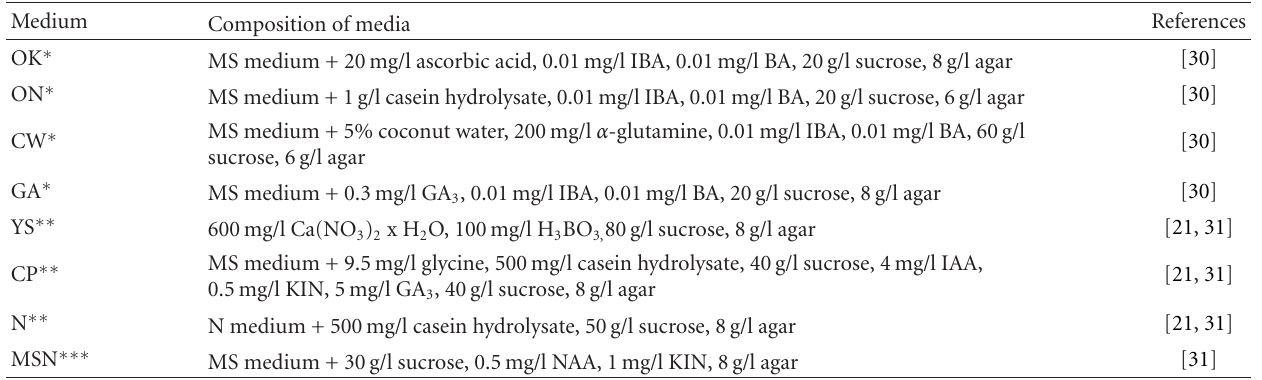
Table 2: Cultivation media used in this study.